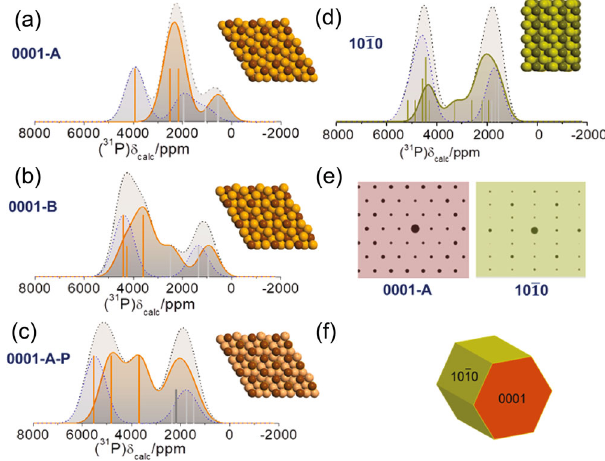
Fig. 4 DFT-calculated 31 P ssNMR spectra of 4 Ni 2 P slabs with different terminating surfaces. NMR spectra from surfaces are in orange/green color, whereas blue color spectral contribution is from the bulk-like interior. The total NMR spectra are shown with dotted lines in gray color. The superimposed orange/olive and gray color lines indicate the calculated isotropic resonances (not including lineshape effects) of the P(1) and P(2) sites, respectively. a 31 P DFT-calculated NMR spectrum of a Ni 2 P slab with (0001-A) termination (super-cell with 50 atoms). b 31 P DFT NMR spectrum of Ni 2 P with (0001-B) termination (49 atoms). c 31 P DFT NMR spectrum of Ni 2 P with 0001 (cid:3) A (cid:3) P ð Þ termination (52 atoms). The dark gray colored bar represents the isotropic resonances of the two surface P adatoms (again with no lineshape effects). d 31 P DFT NMR spectrum of Ni 2 P with ð 10 (cid:1) 10 Þ termination (54 atoms). e The DFT-calculated electron diffraction patterns (EDP) of the (0001-A) and ð 10 (cid:1) 10 Þ terminating slabs, which are the two most common facets in the Ni 2 P nanoparticles. f Schematic presentation of Ni 2 P nanoparticles in the P-excess limit, with the (0001) (red) and the ð 10 (cid:1) 10 Þ (green) facets terminations 17